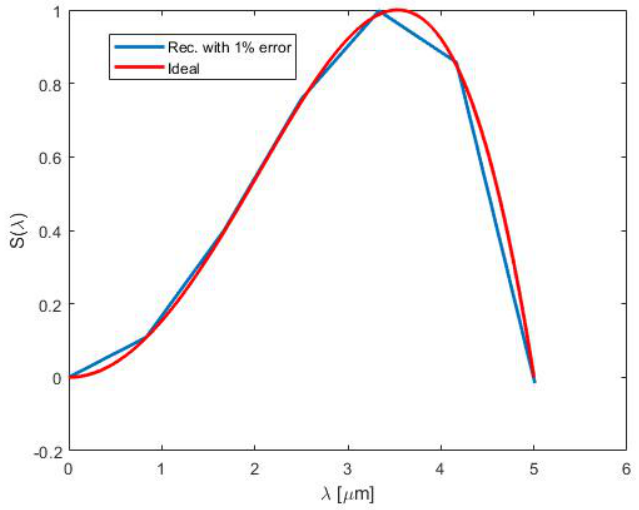
Figure A2. Reconstruction of the spectral response function with power series compared to the 1% voltage error case.